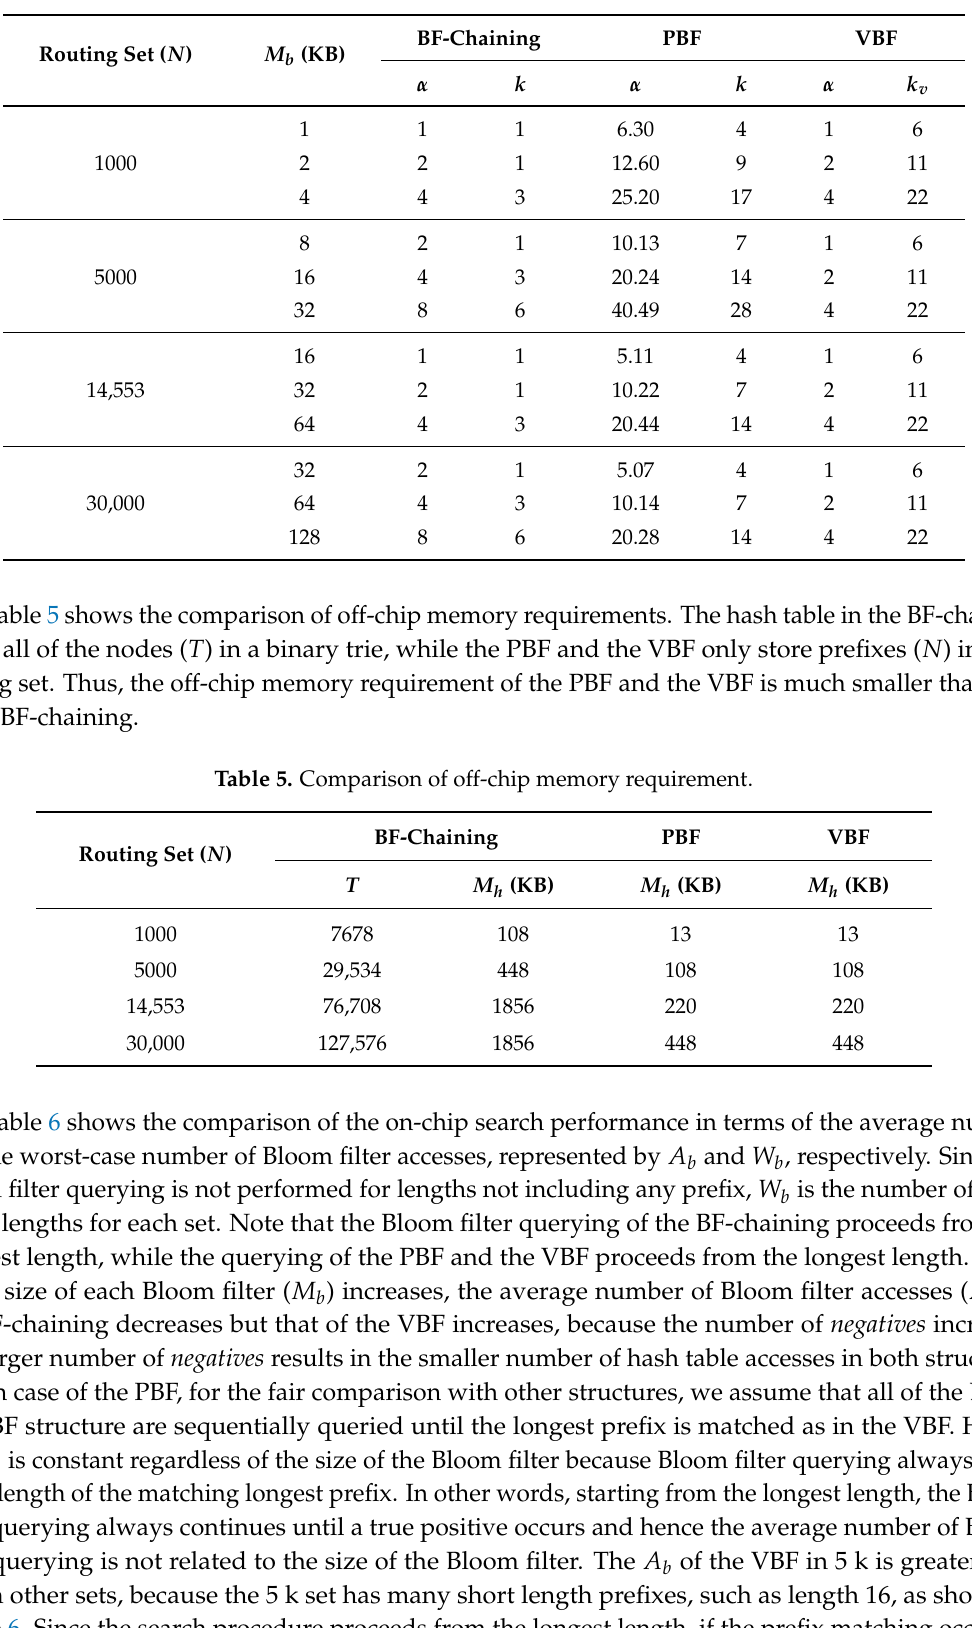
Table 4. Comparison on Bloom filter characteristics.